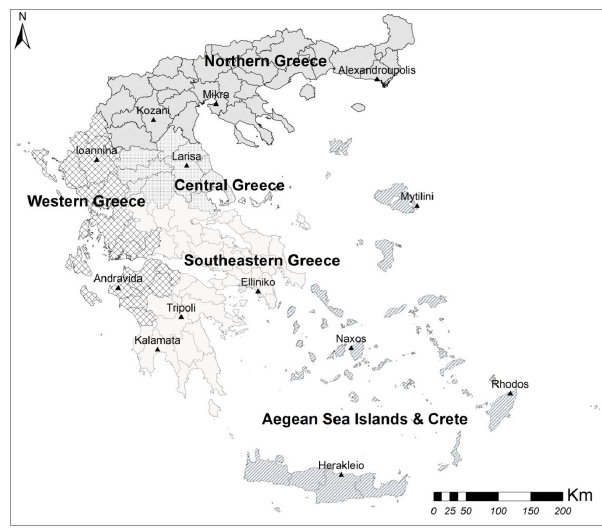
Fig. 1. Division of Greece into five sub-regions for the presentation Figure 1. Division of Greece into five sub-regions for the presentation of the fire base data and 2 of the fire base data and locations of the meteorological stations locations of the meteorological stations used. 3